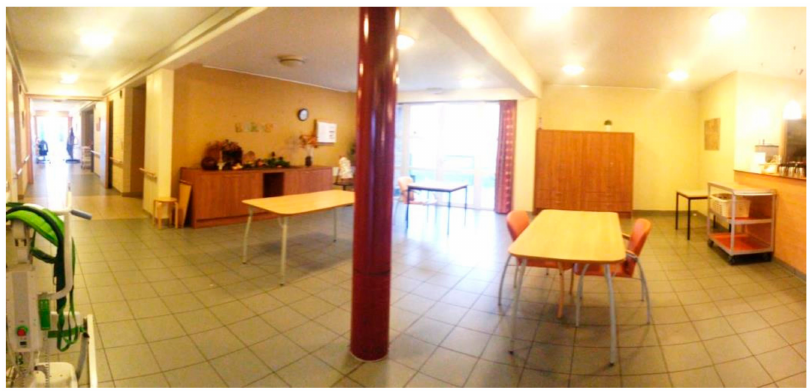
Figure 1. Living room of the case study